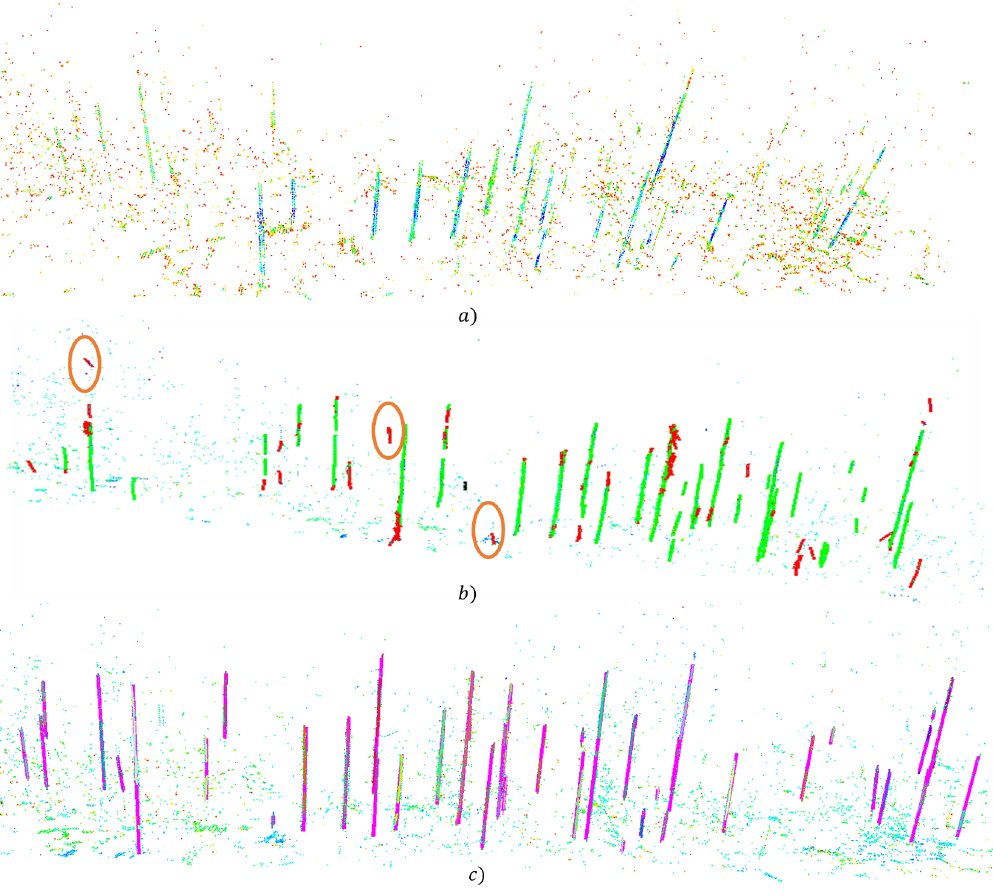
Figure 6. The detection results for a sample plot:(a), (b) and (c) correspond to point, segment and object levels, respectively (see Sections 2.1-2.3). At point level in (a), the red color shows low and blue high probability. The solid green bars in (b) indicate tree stems classified as positive and red bars refer to unmatched tree stems with references. The points which do not belong to the detected stems are removed from analysis and colored as cyan. Orange ellipses outline examples of the false alarms. The fitted magenta lines in (c) represent the reference tree stems which overlap with colored detected stems (ODR with the (cid:96) 1 norm). the analysis.